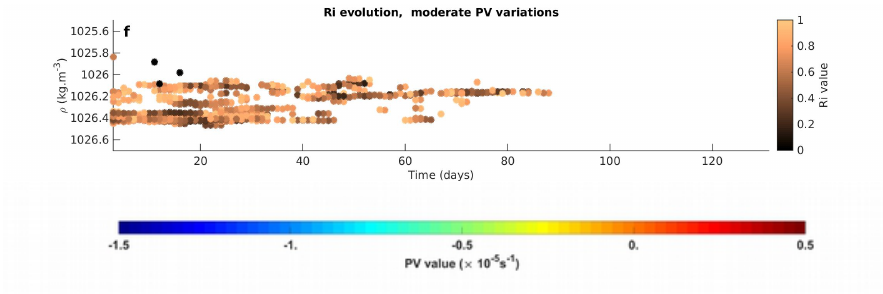
Figure 17. The same as Figure 15 but for particles undergoing a moderate PV change during the evolution; ( a – c ): particles initially located close to the final position; ( d – f ): other particles, coming from along the Equator or African